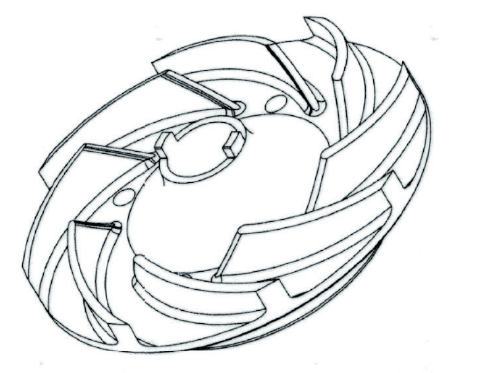
Figure 3. LOx pump impeller hub and blades.